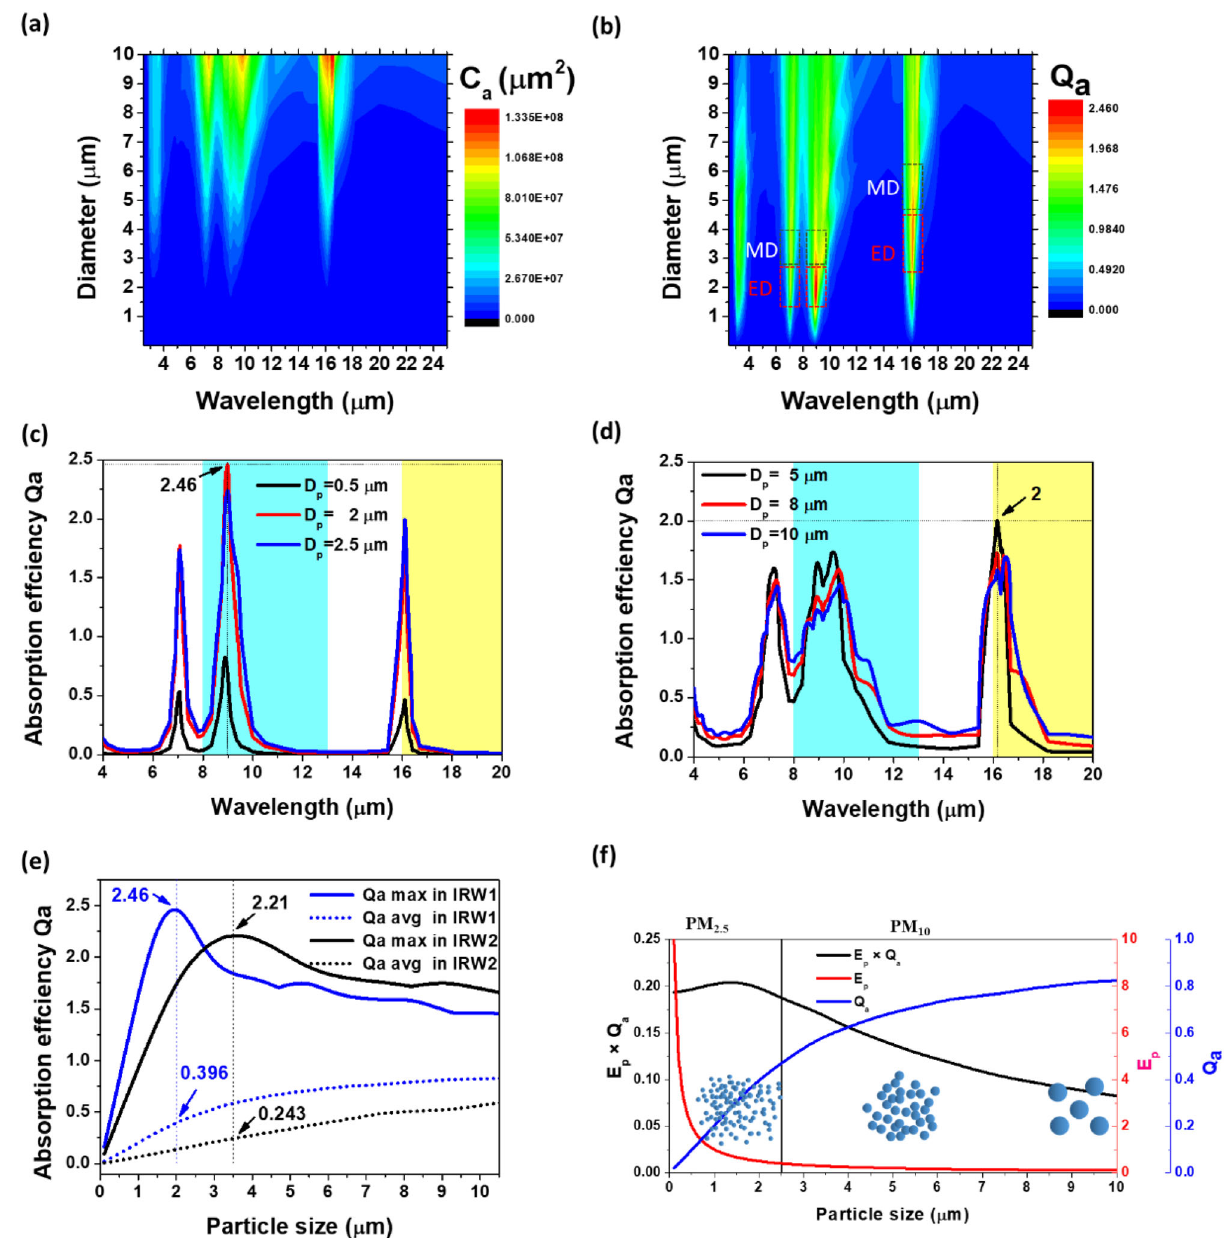
Fig. 2 Absorption ef fi ciency coef fi cient Q a for different sizes of sulfate particles. a , b Contour diagrams of the absorption ef fi ciency factor ( C a ) and ( Q a ) of (NH 4 ) 2 SO 4 particles for wavelengths in the range from 4 to 20 µ m and for diameters ( D p ) from 0.1 to 10 µ m; c Q a spectra obtained for values of D p of 0.5, 2, and 2.5 µ m; d Q a spectra obtained for values of D p of 5, 8, and 10 µ m; e maximum and average values of Q a obtained for values of D p from 0.1 to 10 µ m in IRW1 (blue and blue dotted curves) and IRW2 (black and black dotted curves); f trends in the average values of Q a , the particle number effect ( E p ), and the values of Q a ´ E p in IRW1 for various values of D p